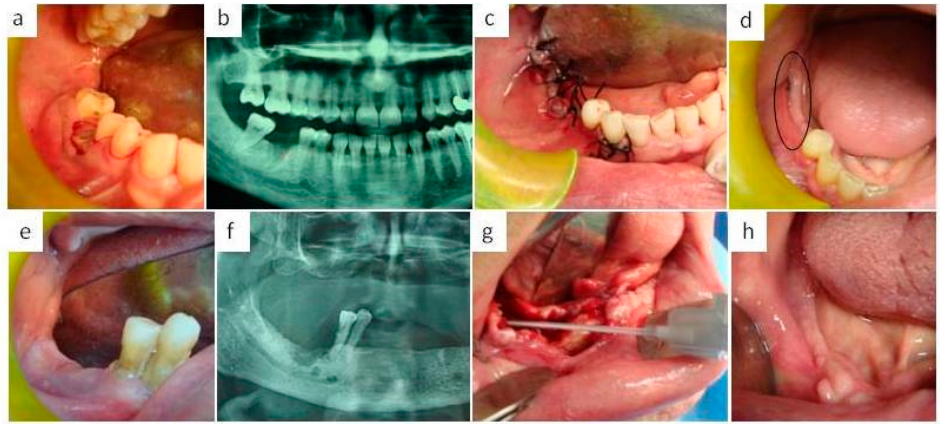
Figure 2. GROUP C: medication-related osteonecrosis of the jaw (MRONJ) of the right mandible in 2 oncologic patients receiving zoledronic acid infusions ( a – f ). Patients underwent surgical resection of necrotic bone, and Aminogam ® gel was applied both within bone cavity and upon stitches only in one patient ( g ) After 20 days, uncompleted healing of the surgical wound with signs of inflammation was detectable in the patient not receiving Aminogam ® gel ( d ), while complete wound healing was observable in the treated patient ( h